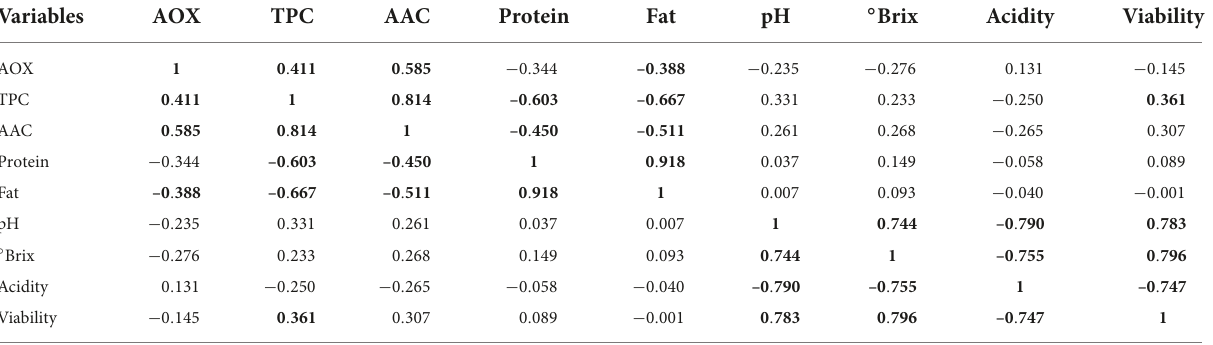
TABLE 2 Pearson correlation coefficient to the nine